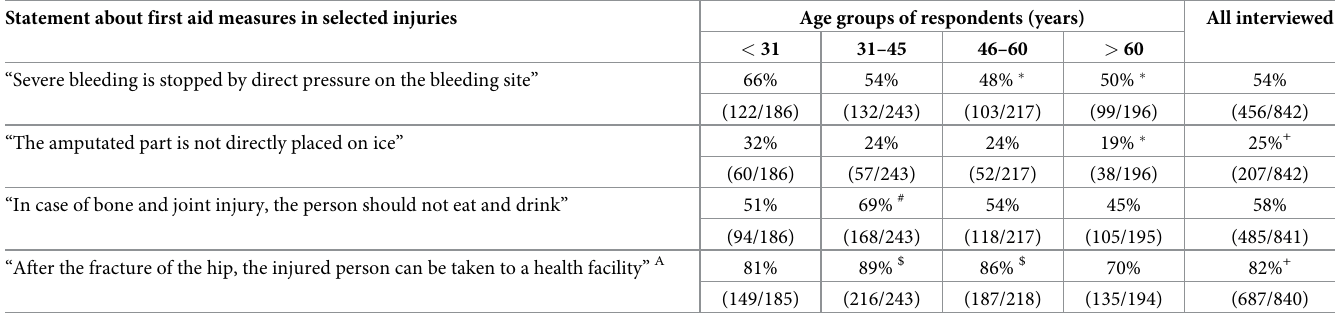
Table 3. Proportions of correct answers to the statements about first aid measures in the selected cases of injuries in the questionnaire. Statement about first aid measures in selected